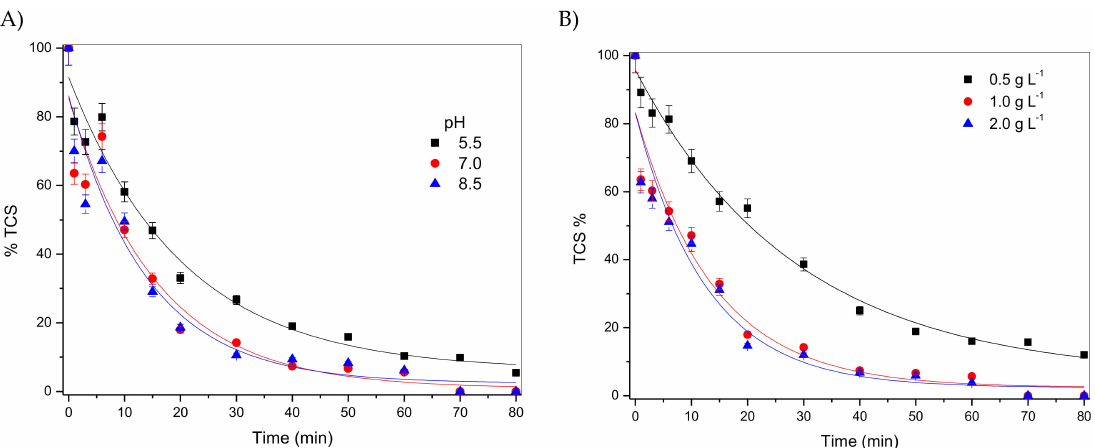
Figure 4. Influence of ( A ) pH (1% Fe/Nb 2 O 5 calcined 773 K, 1.0 g L − 1 ) and ( B ) catalyst mass (pH 7.0, 1.0% Fe/Nb 2 O 5 calcined 773